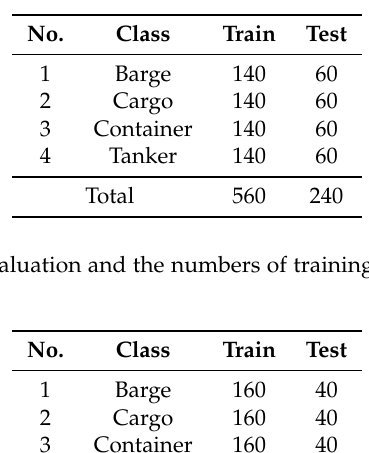
Figure 7. Illustration of the original BCCT200 data. Table 2. Selected classes for evaluation and the numbers of training and test set for the BCCT200-resize data.